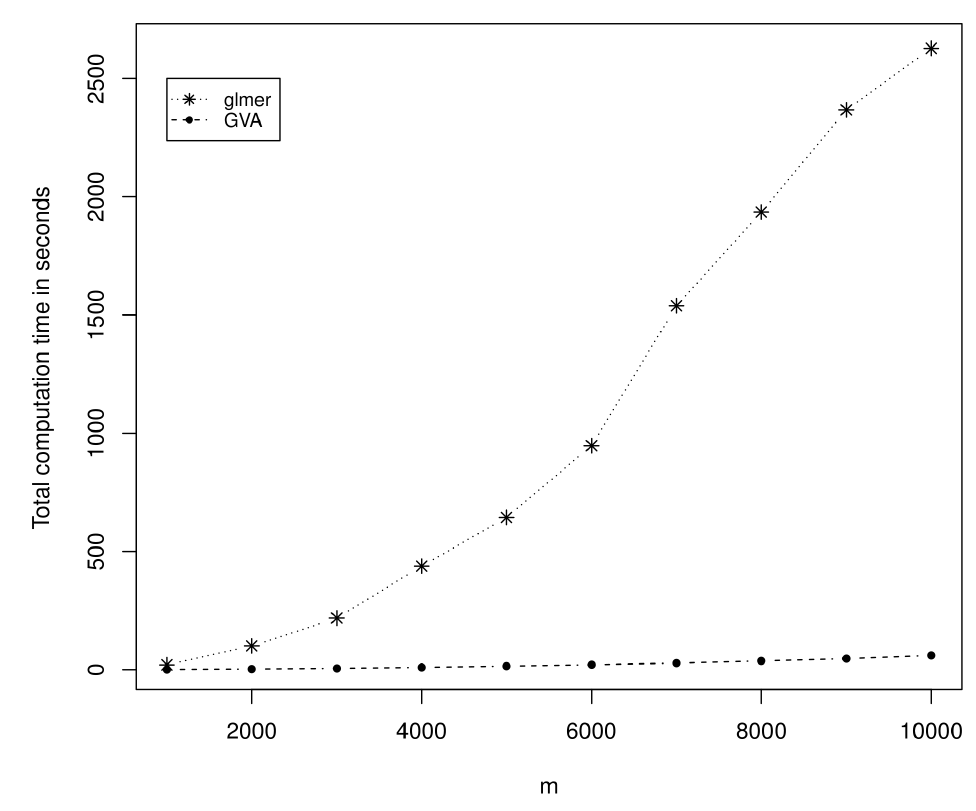
Figure 7. Comparison of the computation time for lme4 and our method for different m , n = m /10, and p =